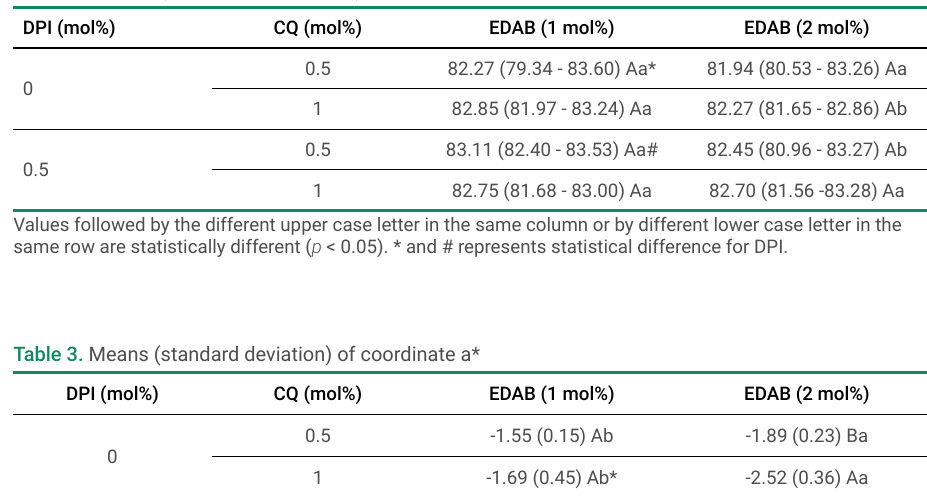
Table 2. Median (minimum - maximum) of coordinate